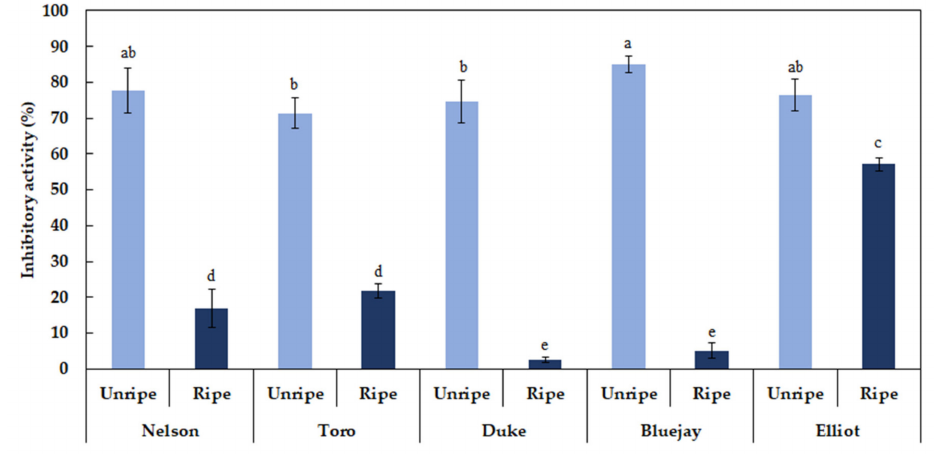
Figure 4. Di ff erent letters ( a – e ) are significant di ff erences by Duncan’s multiple range test ( p <